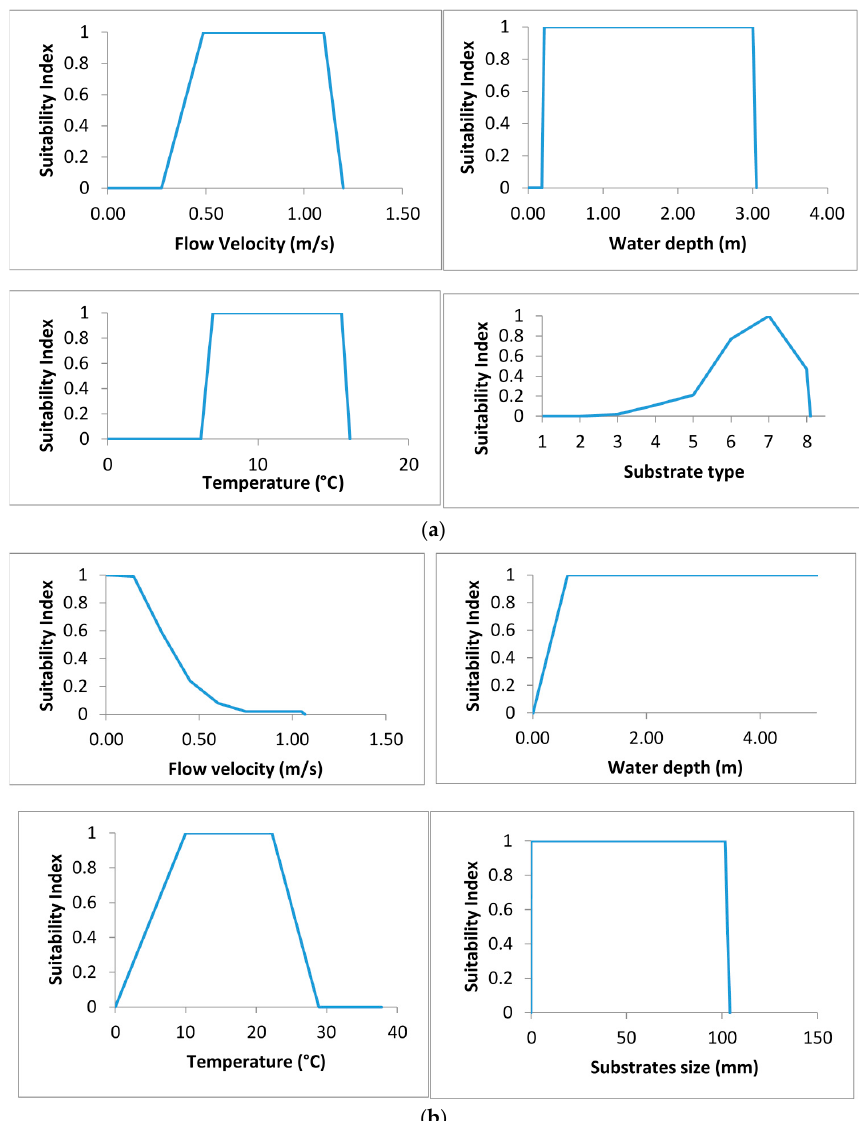
Figure 5. Spawning ( a ) and juvenile ( b ) rainbow trout flow velocity, water depth, temperature and substrates preference curves. (Substrates types: 1 = plant detritus/organic material, 2 = mud/soft clay, 3 = silt (particle size < 0.062 mm), 4 = sand (particle size 0.062 to 2.000 mm), 5 = gravel (particle size 2.0 to 64.0 mm), 6 = cobble/rubble (particle size 64.0 to 250.0 mm), 7 = boulder (particle size 250.0 to 4000.0 mm), 8 = bedrock (solid rock)).